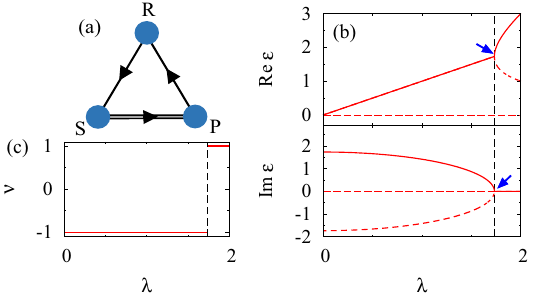
Figure 1. ( a ) Sketch of the RPS cycle. The arrows denote dominance relationship between the strategies for (cid:31) 0 ; “R” beats “S”; “S” beats “P”; “P” beats “R”. The second terms proportional to (cid:31) are introduced between = sites connected by the double line. ( b ) The real- and imaginary-parts of eigenvalues as functions of (cid:31) . An eigenvalue of A ( (cid:31) ) is zero for an arbitrary (cid:31) (see horizontal dashed lines). ( c ) The Z 2 -invariant characterizing the (cid:31) EP. The dashed vertical lines in panels ( b , c ) denote (cid:31) c =